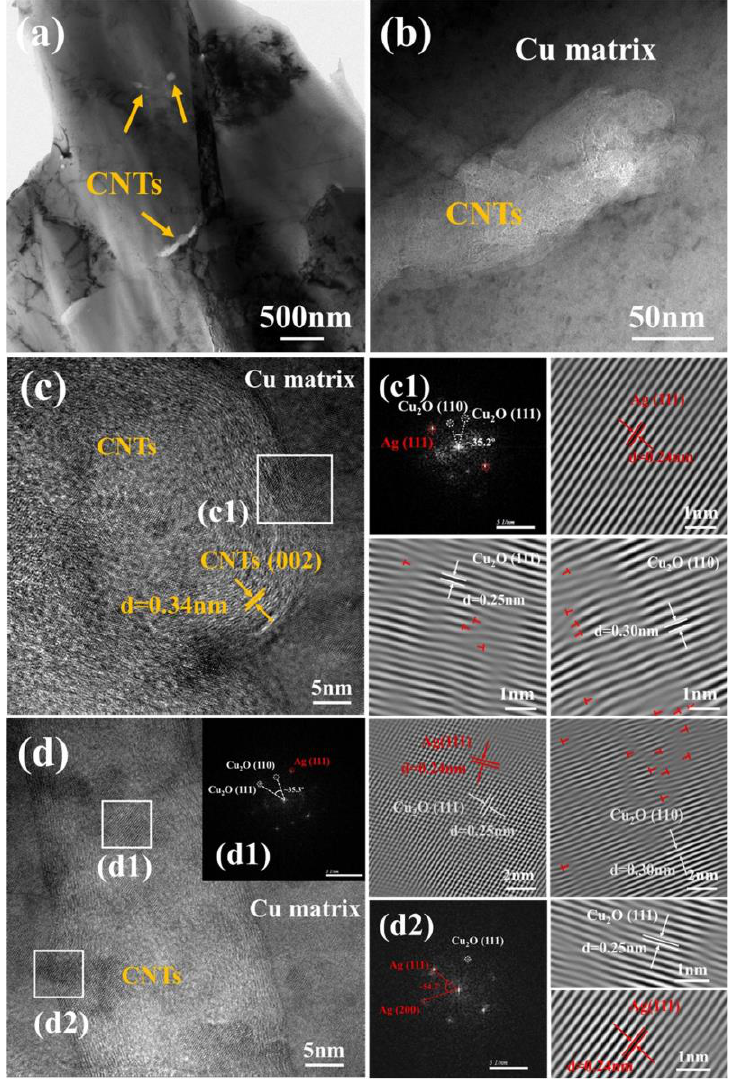
Figure 8. ( a , b ) TEM images of 0.9 vol.% Ag-CNTs/Cu composite; ( c , d ) HRTEM images of Ag-CNTs/Cu composites; ( c1 – d2 ) FFT and IFFT images corresponding to the white boxed areas of ( c , d ), respectively.